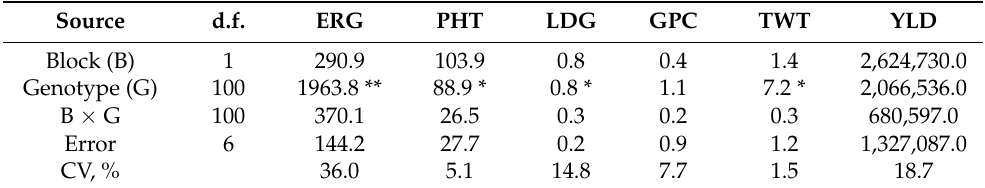
Table 2. ANOVA for ERG, PHT, LDG, GPC, TWT, YLD for parents (TMP16315 and AC Ultima), their progenies (DHs) and a check (Pronghorn), grown at Lethbridge (LET), during 2011. Source